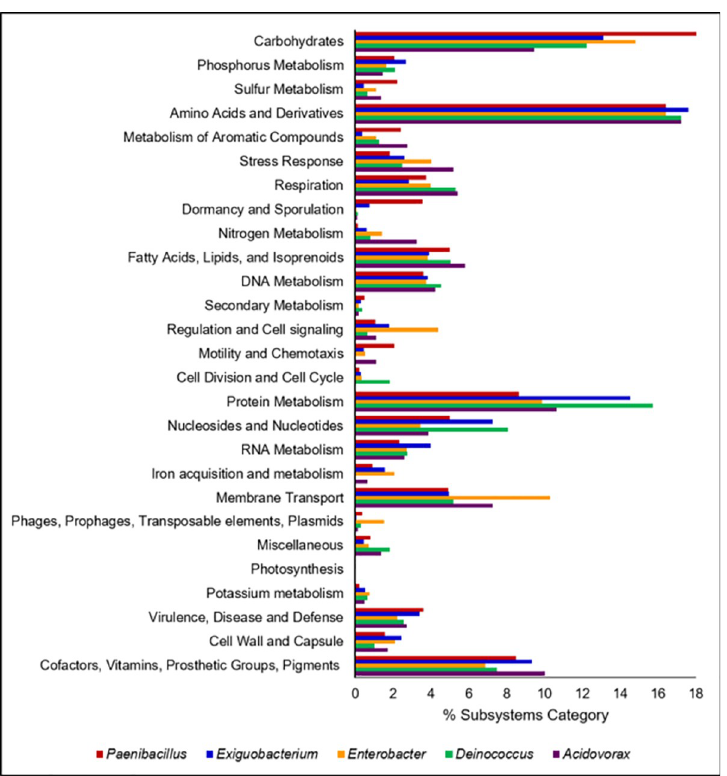
Fig 1. Percent of annotated genes in each Subsystems (SEED) category. Subsystem coverage for each of the isolates was 30% for Exiguobacterium sp. JMULE1, 33% for Enterobacter sp. JMULE2, 23% for Deinococcus sp. JMULE3, 26% for Paenibacillus sp. JMULE4, and 31% for Acidovorax sp.